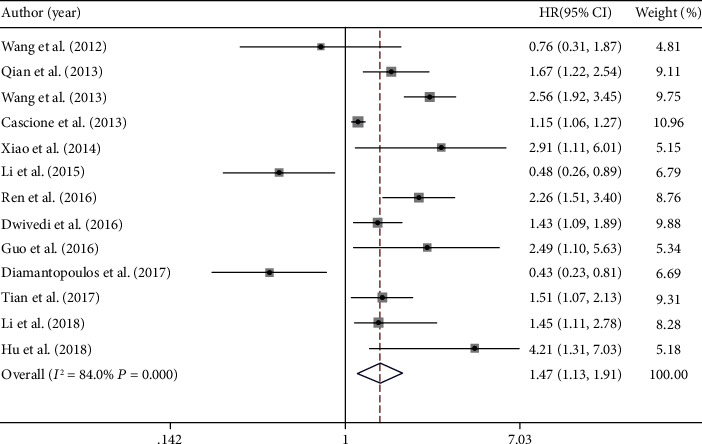
Forest plot for the association between miR-16 expression level and prognosis of solid cancer patients.